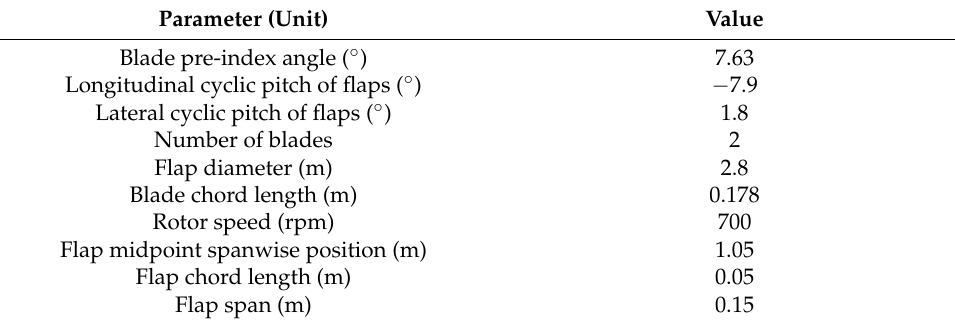
Table 1. Main parameters of the example ECR. Parameter (Unit) Value Blade pre-index angle ( ◦ ) 7.63 Longitudinal cyclic pitch of flaps ( ◦ ) − 7.9 Lateral cyclic pitch of flaps ( ◦